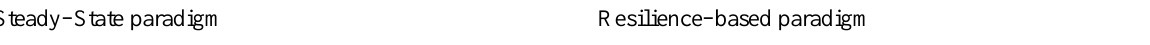
Table 1. Contrast between steady-state management and resilience-based ecosystems management. Steady–State